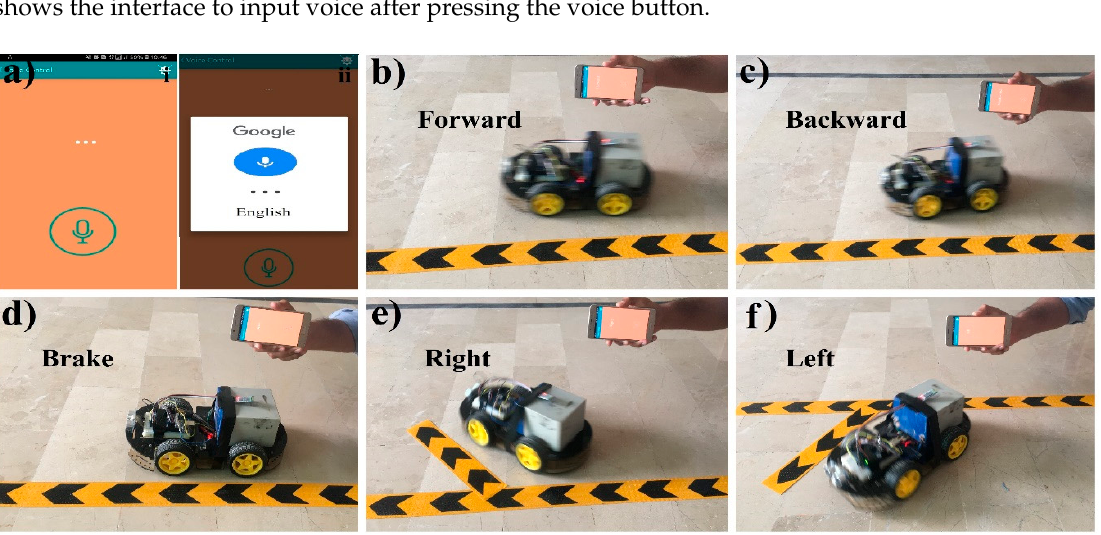
Figure 9. Result diagrams of the automatic robot car controlled with voice recognition in the mobile- application. ( a ) i. Starting interface of the voice recognition android application. ii. Voice is recognized after pressing the voice button of the android application. ( b ) The voice is recognized as a forward command, so the car is moving forward. ( c ) The voice is identified as a backward command, so the car is moving reversely. ( d ) The car is not moving (stopped) because the voice is recognized as a brake. ( e ) The car is moving to the right direction as the voice is identified as a right command. ( f ) The voice is recognized as a left command, so the car is moving to the left direction. The complete demonstration video of the proposed system is available online [85].